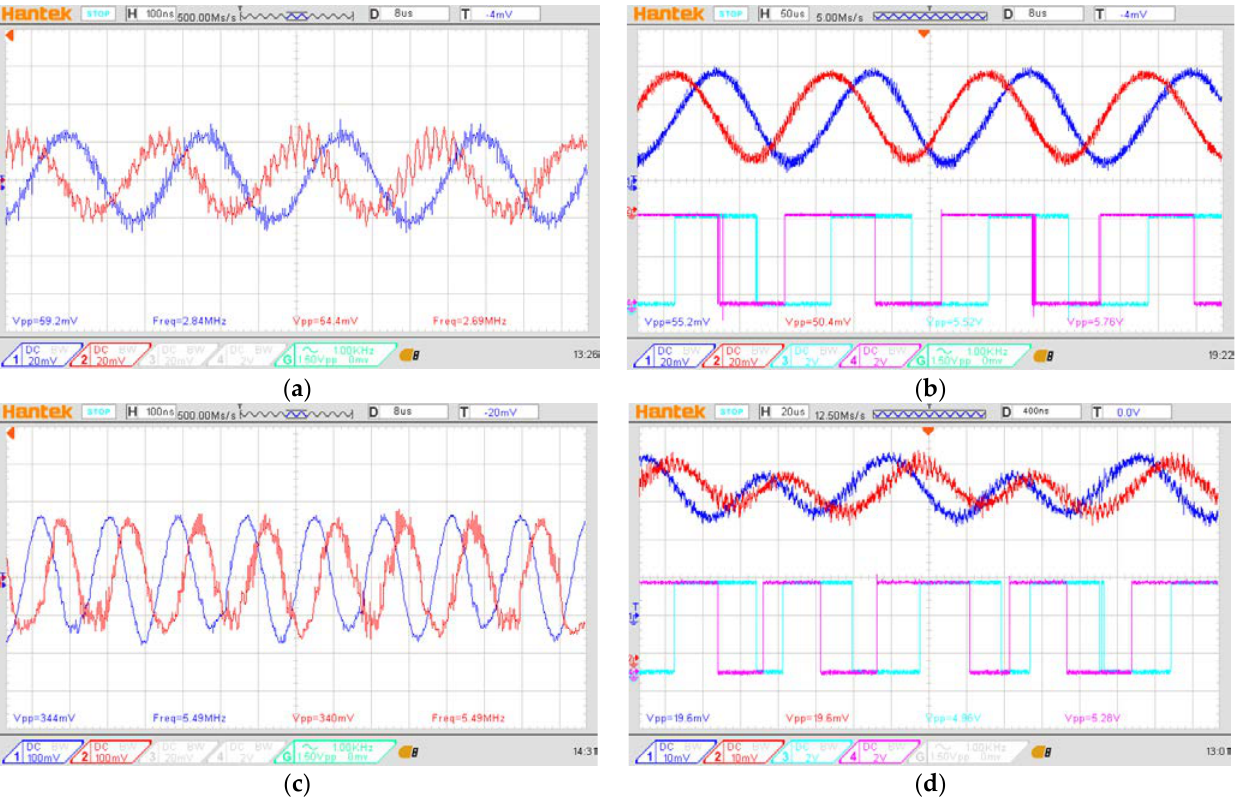
Figure 12. Experimental results: ( a ) the beat frequency of the reference signal (navy blue) and measurement signal (red), ( b ) the encoded signal of the controlled experiment, ( c ) the beat frequency of the reference signal (navy blue) and measurement signal (red) after the 1st-order interpolator, ( d ) the encoded signal from the 1st-order interpolator.